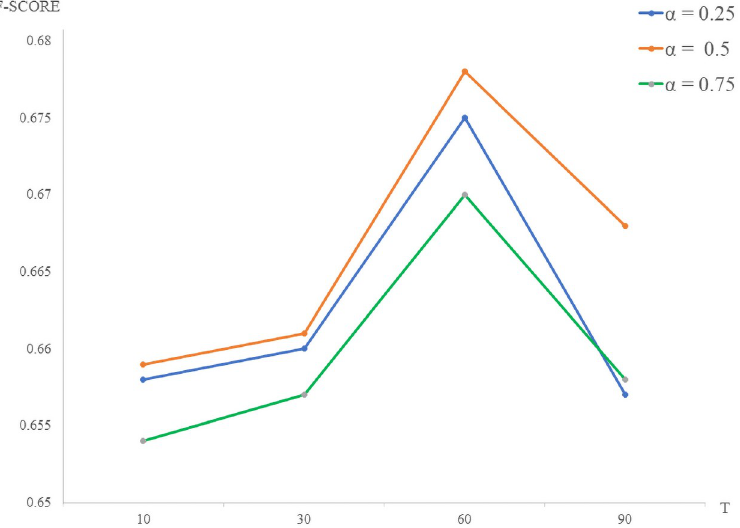
Fig 5. F-score curves with the variation of parameter α and T . Among them, α is the parameter of balancing the soft and hard labels in the knowledge distillation loss, and T is the temperature, which is used to adjust the smoothness of prediction distribution in knowledge